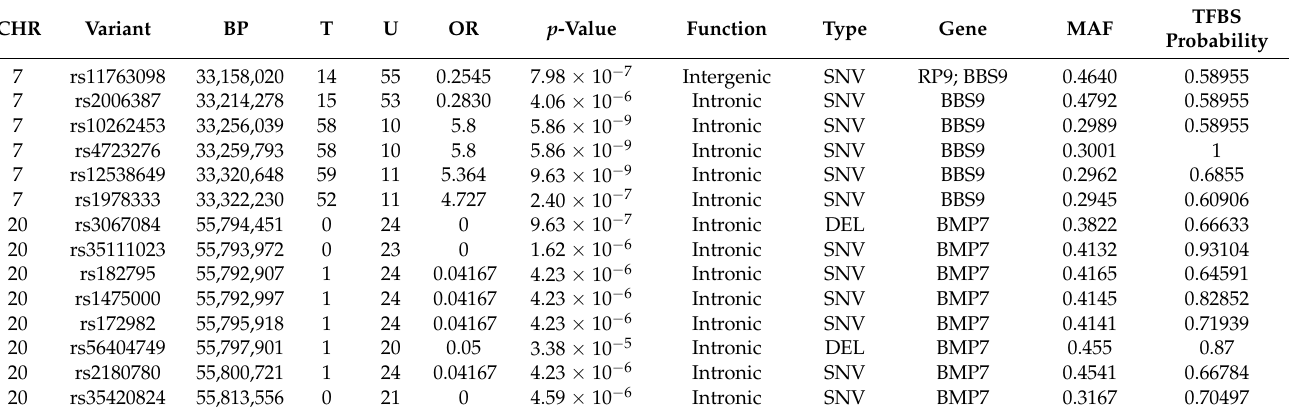
Table 4. Selected potential causal variants in chromosome 7 and 20 target regions from mNCS leave-one-out